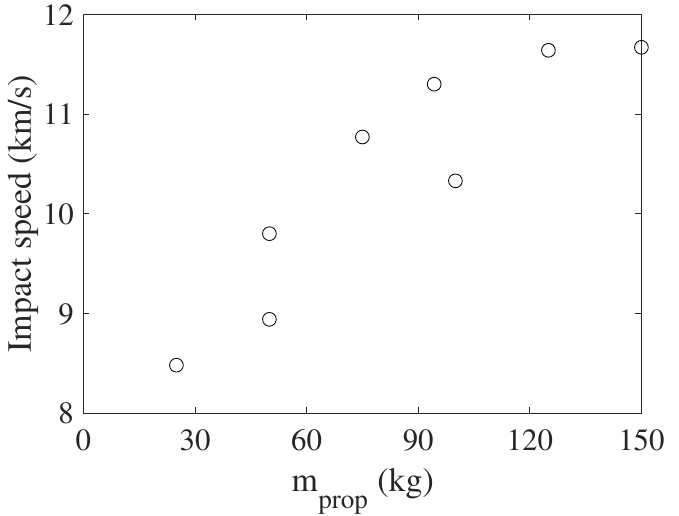
Figure 1. Variation of the impact speed with propellant mass ( C 3 = 4.676 km 2 s − 2 , P source = 7330 W, and Φ = 0.5).